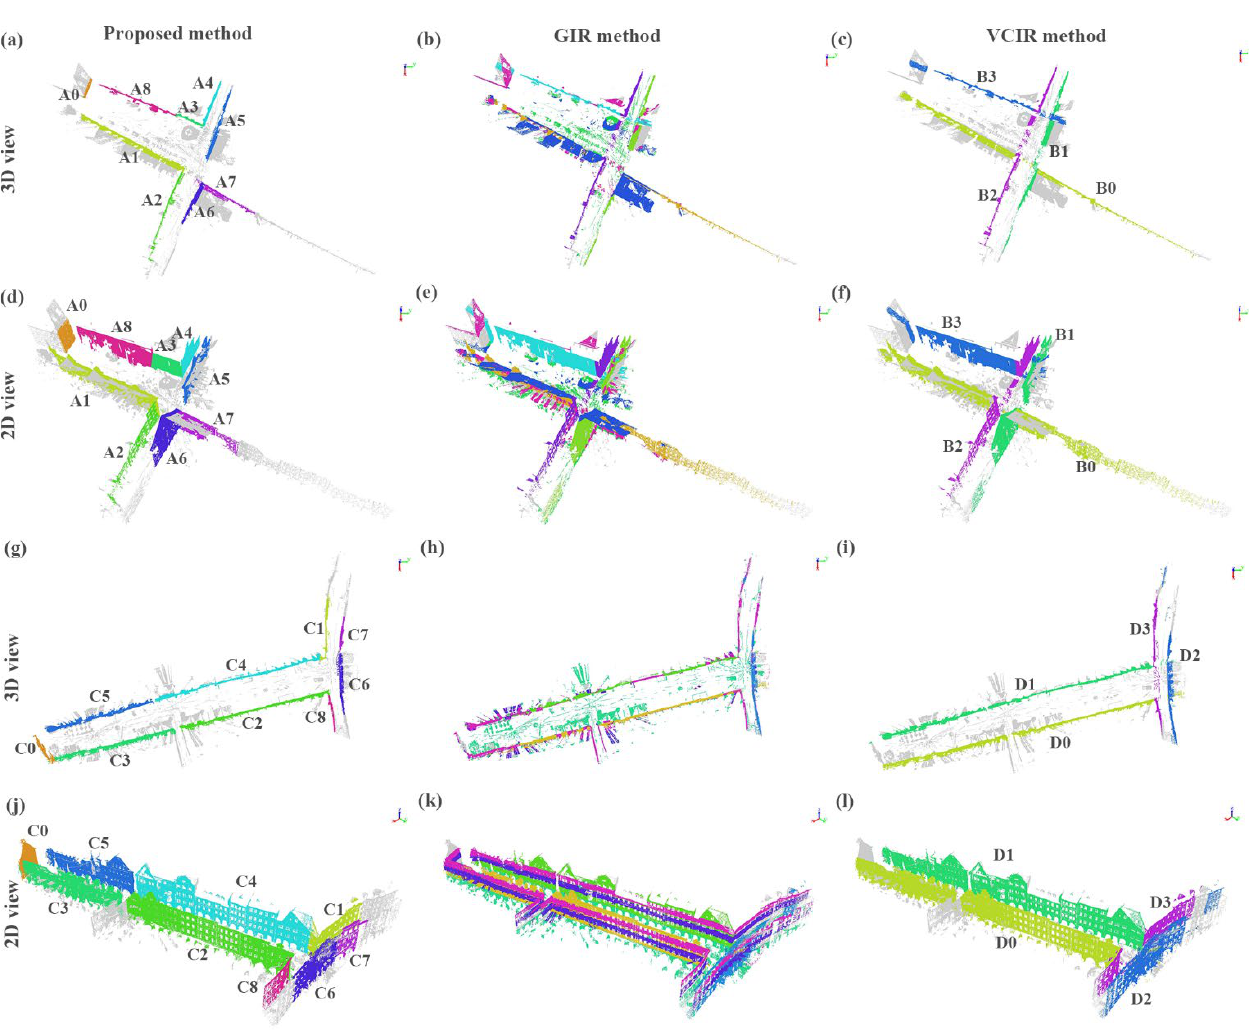
Figure 14. Facade extraction with the Semantic3D.Net Benchmark dataset: ( a – c ) results of the “domfountain” scene in 2D view extracted by the proposed method, GIR method, and VCIR method, respectively; ( d – f ) results of the “domfountain” scene in 3D view extracted by the proposed method, GIR method, and VCIR method, respectively; ( g – i ) results of the “marketsquarefeldkirch” scene in 2D view extracted by the proposed method, GIR method, and VCIR method, respectively; and ( j – l ) results of the “marketsquarefeldkirch” scene in 3D view extracted by the proposed method, GIR method, and VCIR method, respectively. Different colors were used for different facades and gray was used for nonfacade point clouds. Capital English letters were used to label these facades.